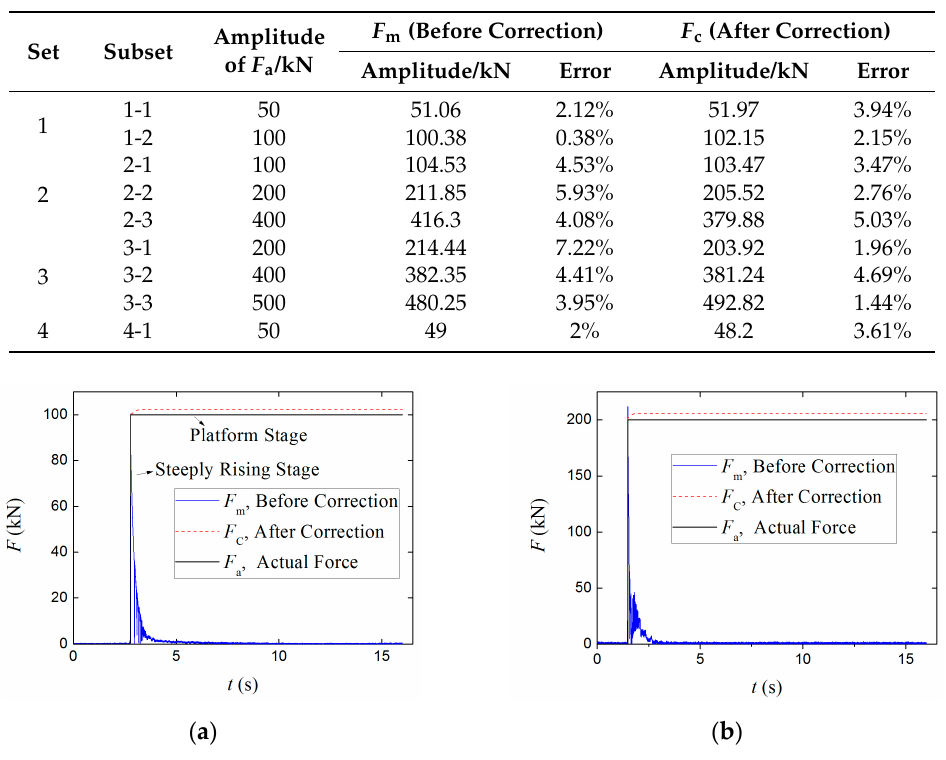
Figure 19. ( a ) Comparisons of F m , F c and F a corresponding to subset 1-2; ( b ) Comparisons of F m , F c and F a corresponding to subset 2-2.